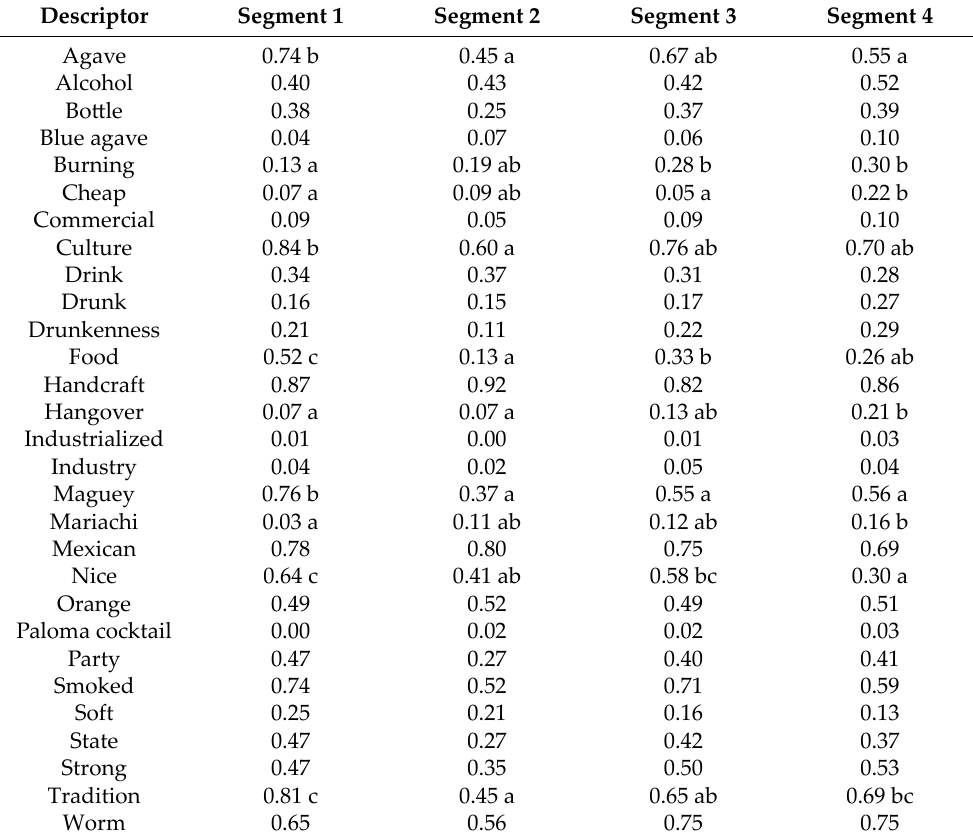
Table 7. Proportions of selected words per segments to describe